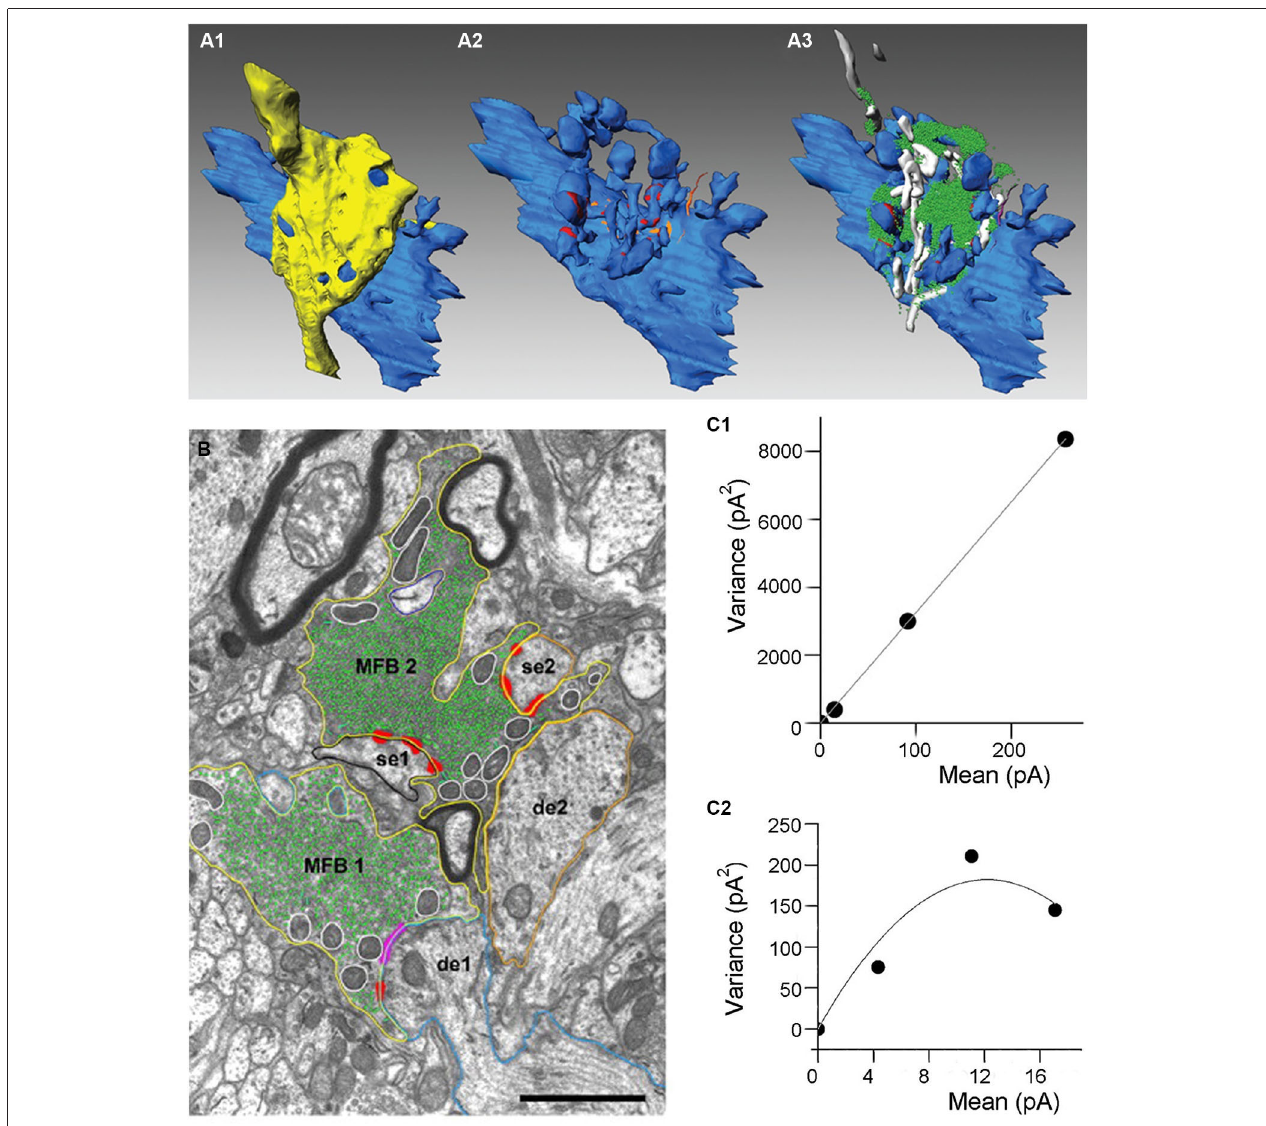
(MFB1, MFB2). Both boutons outlined in yellow terminate on different dendritic segments (de1, blue contour; de2, orange contour), but preferentially on spiny excrescences (se1, black contour; se2, orange contour). Active zones (red), puncta adherentia (magenta), mitochondria (white contours), and individual synaptic vesicles (green). Scale bar corresponds to 1 µ m, adapted from Rollenhagen and Lübke (2007). (C) Variance-mean analysis of mossy fiber-CA3 pyramidal cell (C1) and mossy fiber-interneurone (C2) synapses. Data obtained at three different calcium conditions (1 mM, 2.5 mM and 3.8 mM of CaCl 2 ). Solid lines correspond to either liner (C1) or parabolic fit (C2) . Adapted from Lawrence and McBain